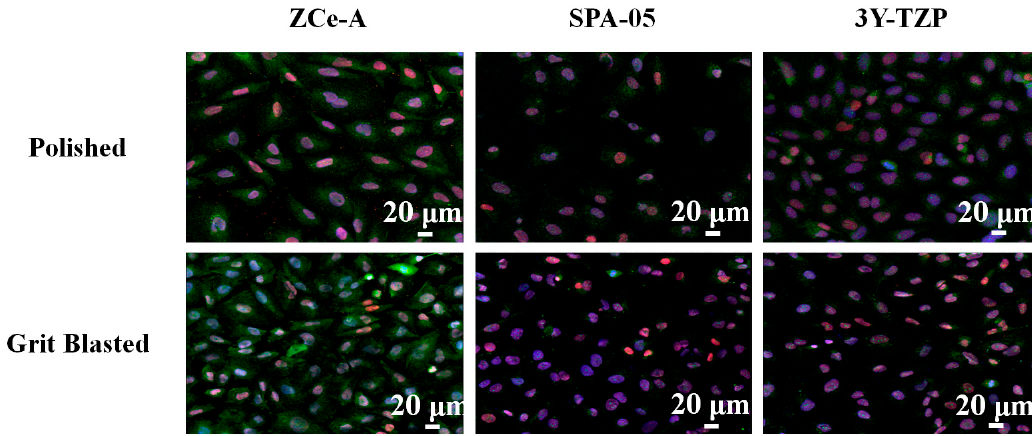
Figure 3. SPARC (green)—RUNX2 (red)—DAPI (blue) staining of SAOS-2 cells incubated for 48 h on the surface of polished and grit-blasted ZCe-A, SPA-05, and 3Y-TZP samples. Table 2. Surface roughness values of different peaks and valleys that were randomly selected along the ceramic implant.